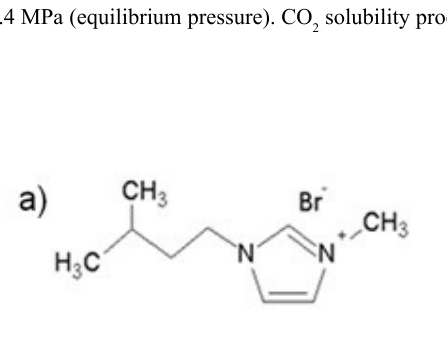
Figure 1. ILs structure: a) mbmim[Br] b) mbmim[Tf